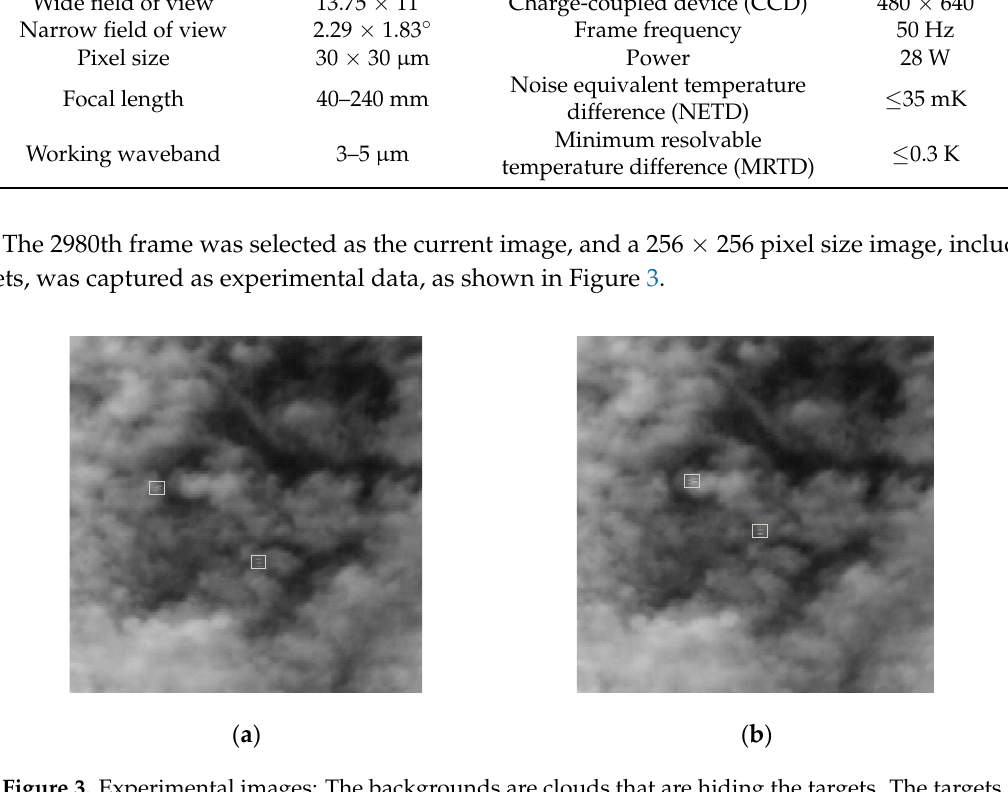
Figure 3. Experimental images: The backgrounds are clouds that are hiding the targets. The targets are marked with a white square frame, representing 16 and 11 pixels. ( a ) 2979th frame image and ( b ) 2980th frame image.